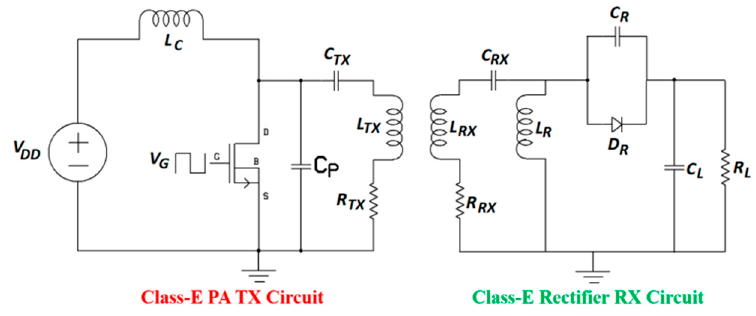
Figure 7. Schematic of class-E PA and rectifier system for NRIC.